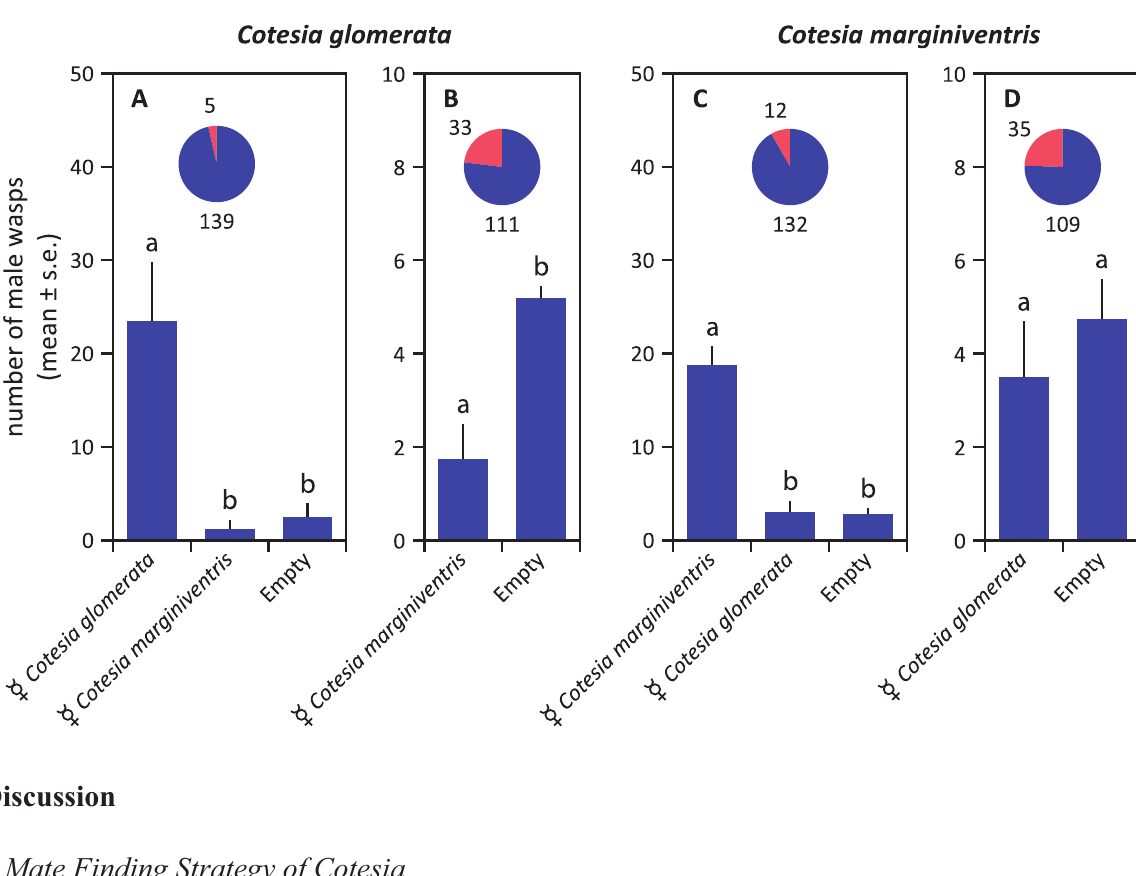
Figure 5. Cross-attractant responses of male wasps, C. glomerata ( A , B ) and C. marginiventris ( C , D ), to con- and inter-specific female cues in a six-arm olfactometer. Interspecific cues were either tested in combination with conspecific cues ( A , C ) or alone ( B , D ). The proportion of wasps that showed no response, i.e. , that did not choose an arm, is given in red in the pie chart, supplemented with the absolute numbers of wasps. Statistical differences ( p < 0.05) are indicated with different letters above the